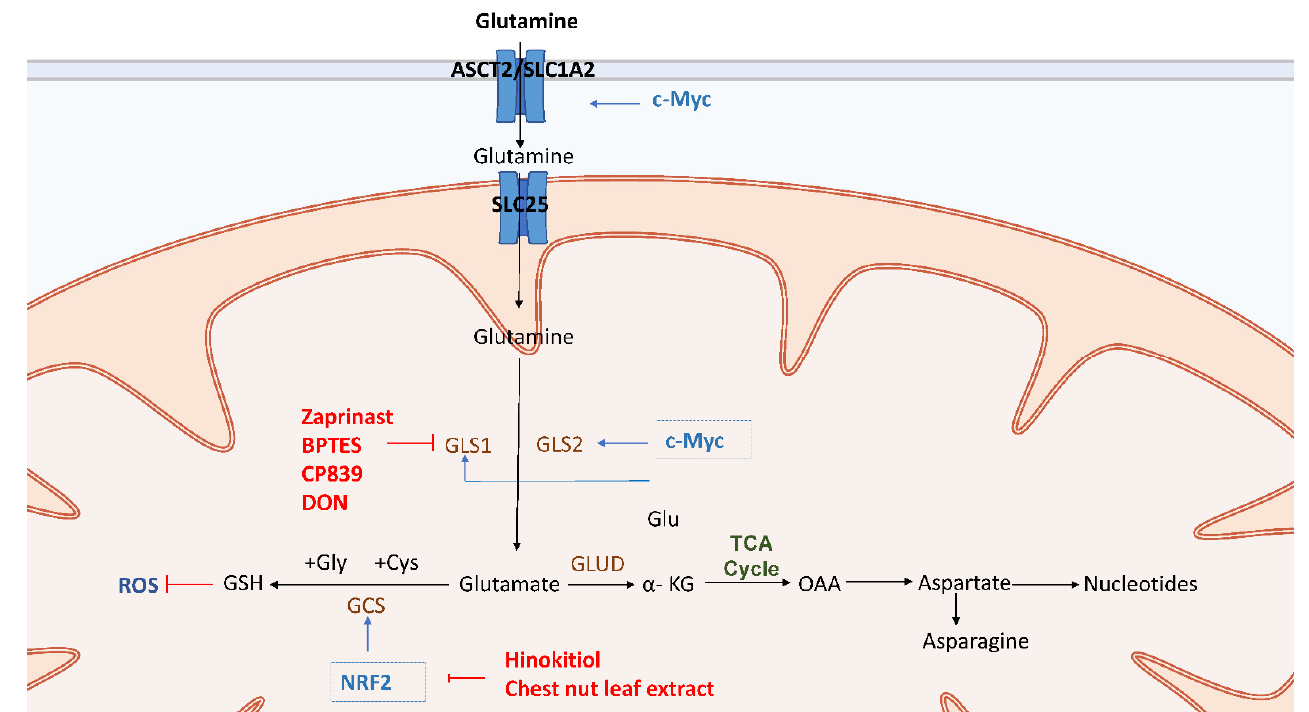
Figure 3. Glutaminolysis provides precursors for the biosynthesis of nucleic acids, lipids, amino acids and glutathione. Glutamine is obtained by tissue cells through ASCT2 (SLC1A5) and transformed into glutamate through glutaminase GLS1 and GLS2. Glutamate is then metabolized by glutamate dehydrogenase (GLUD) or by transaminase to generate α -KG, which serves as an anaplerotic substrate in the TCA cycle. Oncogene c-MYC induces overexpression of glutamine importers ASCT2 and GLS transcription. Nuclear factor-erythroid 2-related factor 2 (Nrf2) is a transcriptional regulator that binds to anti-oxidative genes promoter to maintain cellular redox status by promoting the expression of antioxidant enzymes such as gamma-glutamyl cysteine synthetase (GCS), an enzyme that generates GSH. Multiple therapeutic targets for GLS in CSCs glutaminolysis. Bis-2-(5-phenylacetamido-1,3,4-thiadiazol-2-yl) ethyl sulfide (BPTES) and CB-839 are allosteric inhibitors of GLS1, which inhibits the influx of glutamine derivatives into the TCA cycle. Zaprinast is a phosphodiesterase 5 inhibitor and an asthma drug that could effectively sensitize cancer stem cells and increase apoptosis through intracellular ROS accumulation in combination with Zaprinast and BPTES. Lastly, azaserine, acivicin, and 6-diazo-5-oxo-L-norleucine (DON) are glutamine analogs that inhibit the activity of GLS1. Nrf2 inhibitors are another potential therapeutic agent for CSCs. Hinokitiol has recently been discovered to suppress Nrf2 expression in glioma CSCs, resulting in decreased self-renewal capacity, migration, invasiveness, and colony-forming ability. In addition, treatment with chestnut leaf extract blocked the activation of the Nrf2 antioxidant protection in MCF-7-derived breast CSCs. Combination therapy of Castanea crenata leaf extract with paclitaxel could dramatically increase the death of cancer cells.